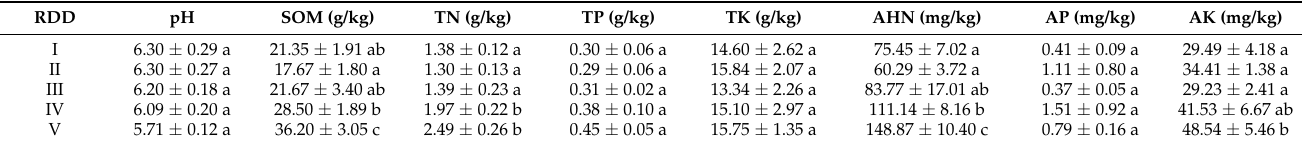
Table 4. A comparison of the soil chemical properties in areas with different rocky desertification degrees in northern Guangdong. Note: Rocky desertification degree (RDD), pH value (pH), Soil organic matter (SOM), Total nitrogen (TN), Total phosphorus (TP), Total kalium (TK), Alkaline hydrolysis nitrogen (AHN), Available phosphorus (AP), Available kalium (AK). The same